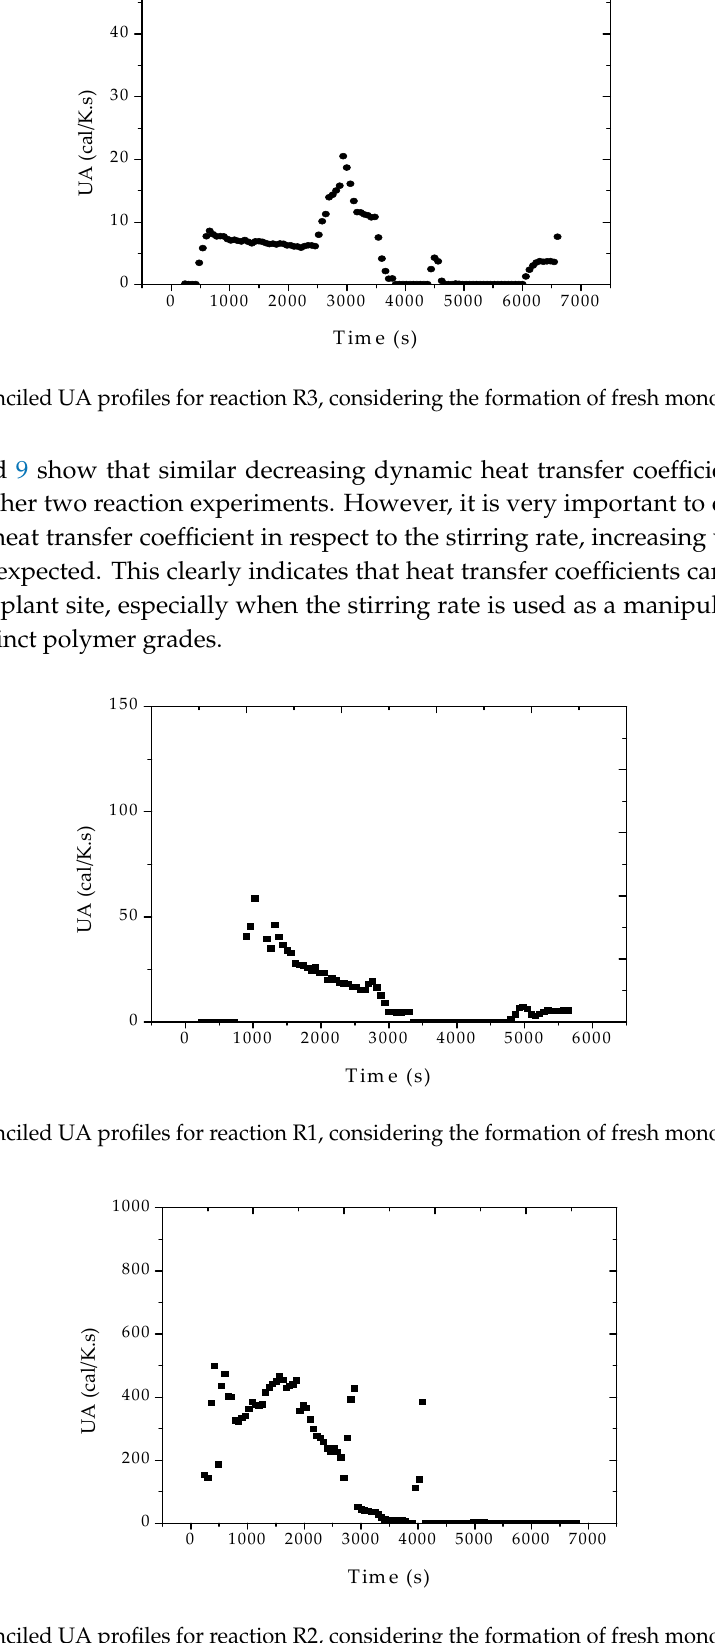
Figure 9. Reconciled UA profiles for reaction R2, considering the formation of fresh monomer droplets.